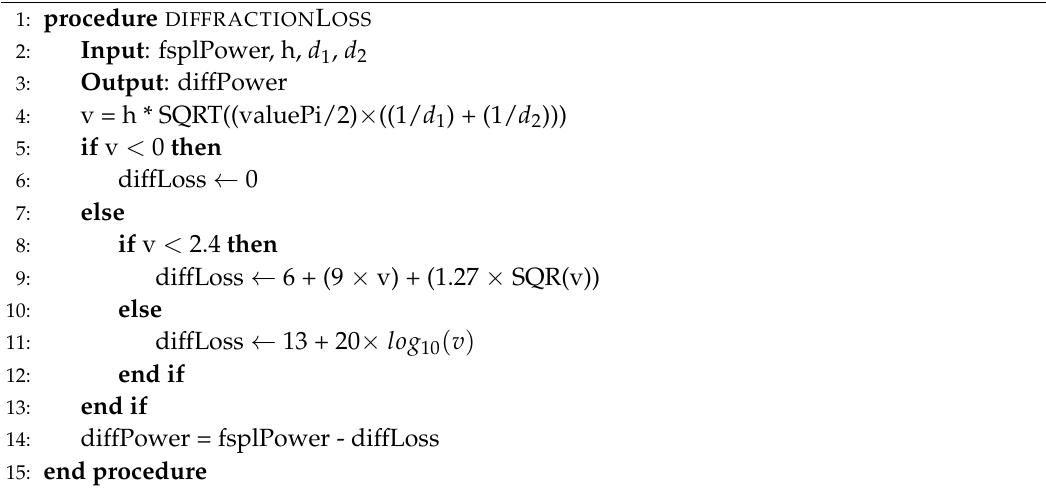
Algorithm 3 Received signal power in the Single Knife-Edge Diffraction